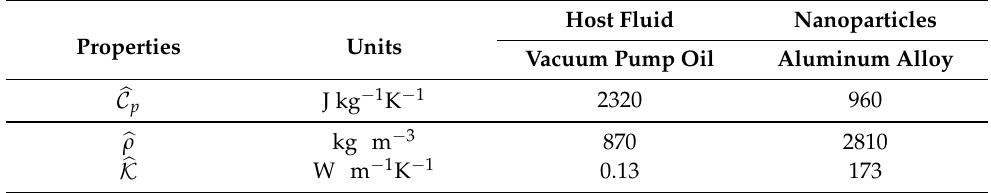
Table 3. Computational values for thermal and physical characteristics of aluminum alloy nanoparti- cles and vacuum pump oil